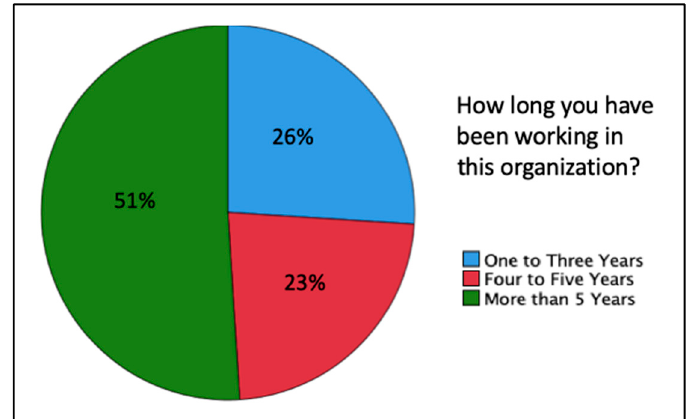
Figure 2 . Respondent Working Years. Figure 2. Respondent Working Years.